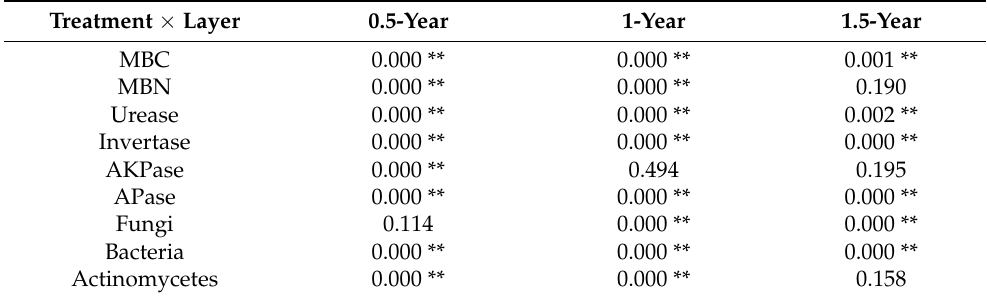
Table 4. Interaction of five fertilization types and two soil layers in soil microbial content of Pinus tabuliformis .